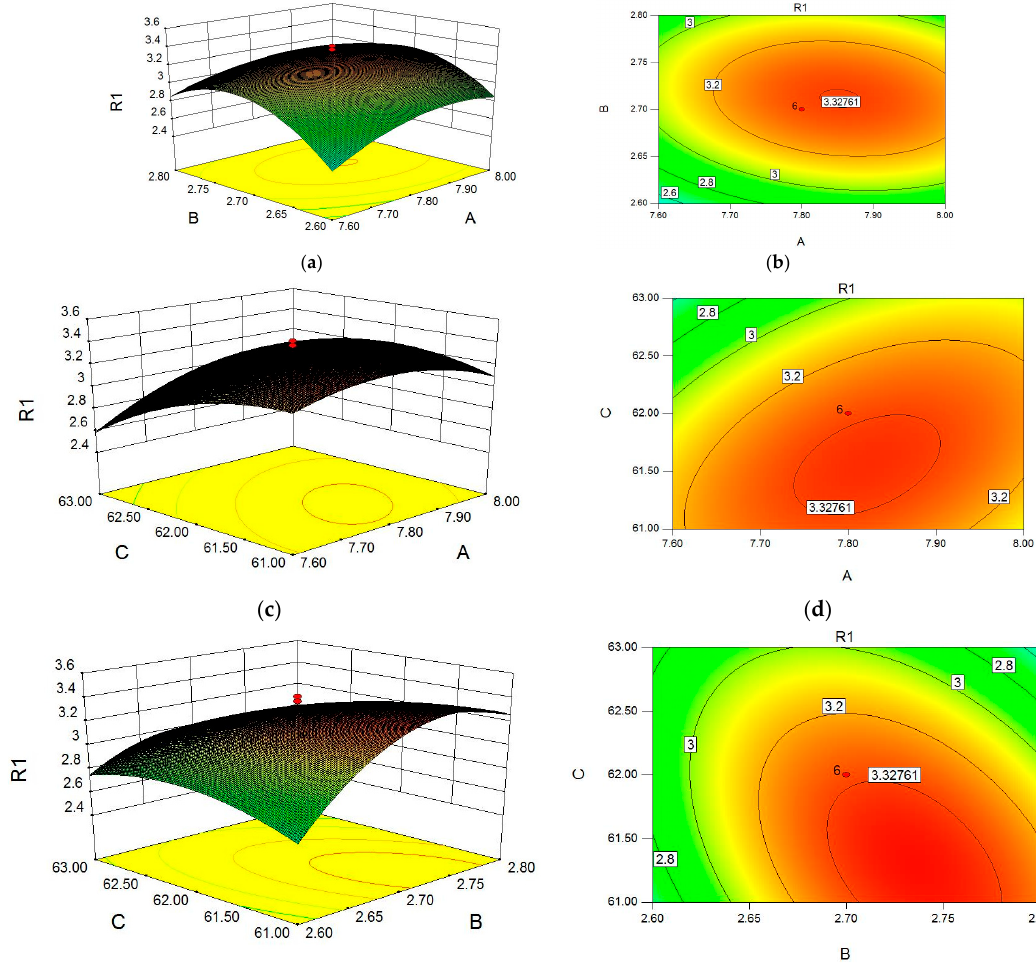
Figure 1. Response surface plot and contour plot showing interaction effects of A (pH value) and B (cellulase) ( a , b ), A (pH value) and C (ratio of water to material) ( c , d ), B (cellulase) and C (ratio of water to material ( e , f ) on the polysaccharide yield.